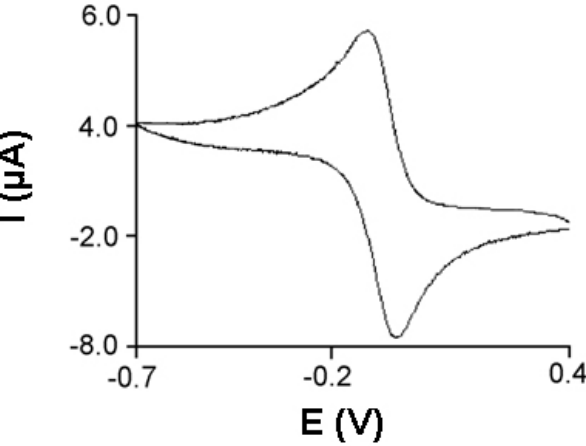
Figure 3. Cyclic voltammogram (versus saturated calomel electrode) for 1 at a scan rate of 0.02 V s − 1